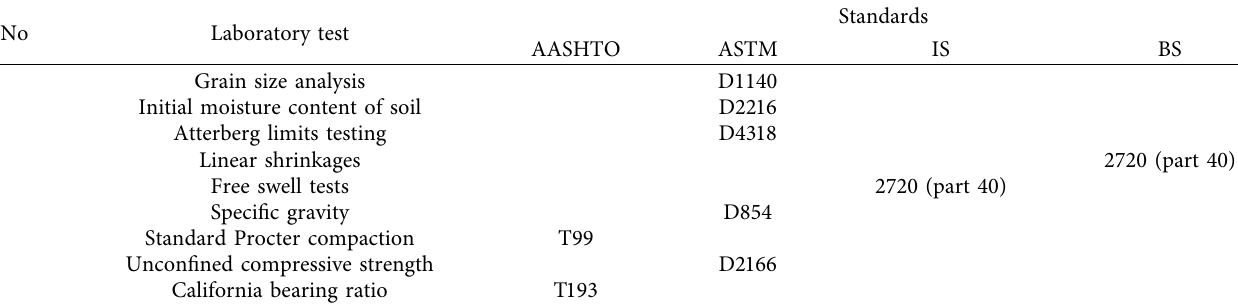
Table 3: Standards and specifcations employed in the study.